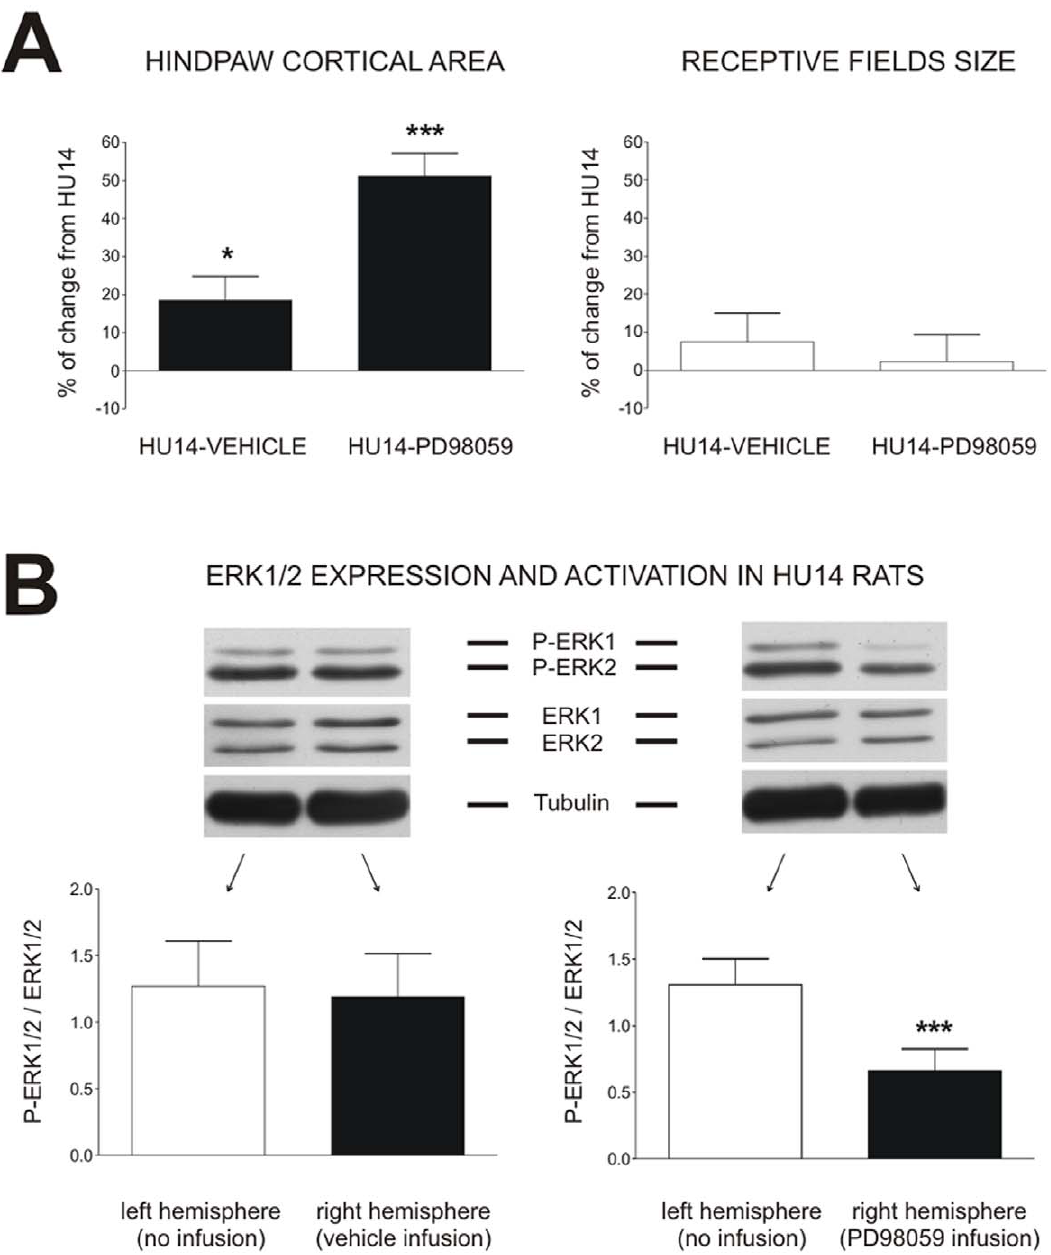
Figure 5. ERK1/2 inhibition prevents cortical map plasticity induced by hindlimb unloading. (A) Effect of vehicle or PD98059 ERK1/2 inhibitor chronic infusion in the right somatosensory cortex on the hindpaw cortical area and the receptive fields size. Data are expressed as percentage of change from HU14 group. ( P , 0.05) and ( P , 0.001) indicate a significant difference from HU14 group. (B) Effect of vehicle or PD98059 ERK1/2 inhibitor chronic infusion in the right somatosensory cortex on ERK1/2 expression and activation. Representative western blots of P- ERK1/2, total ERK1/2 and a -tubulin expression in the left and right somatosensory cortices, and histograms showing ERK1/2 activation (ratio between P-ERK1/2 and ERK1/2). ( P , 0.001) indicates a significant difference between left and right somatosensory cortices.